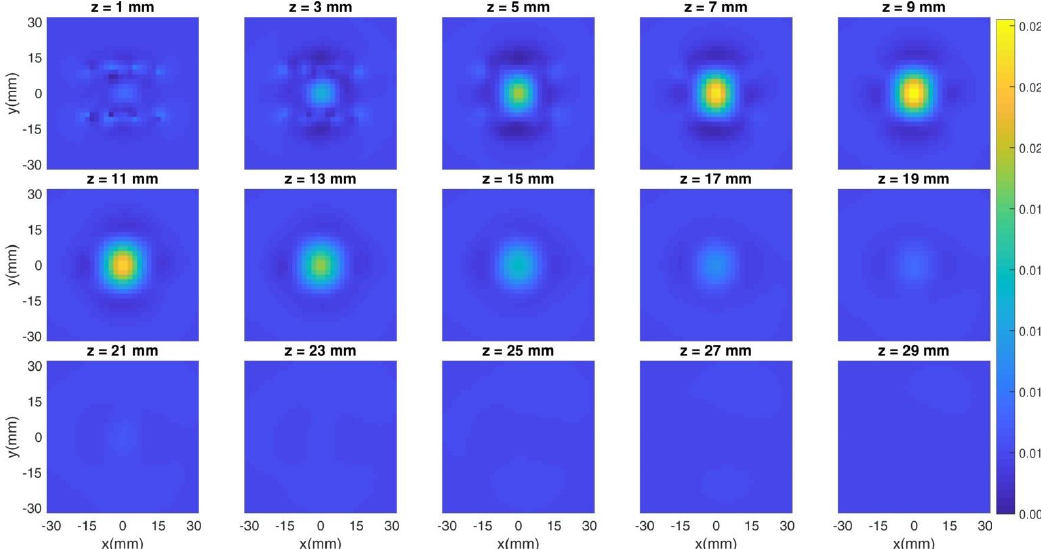
Figure 8. Cross sections of the simulated tomography at different depths. The inclusion is set in the center of the x-y plane and at a 10 mm-depth.